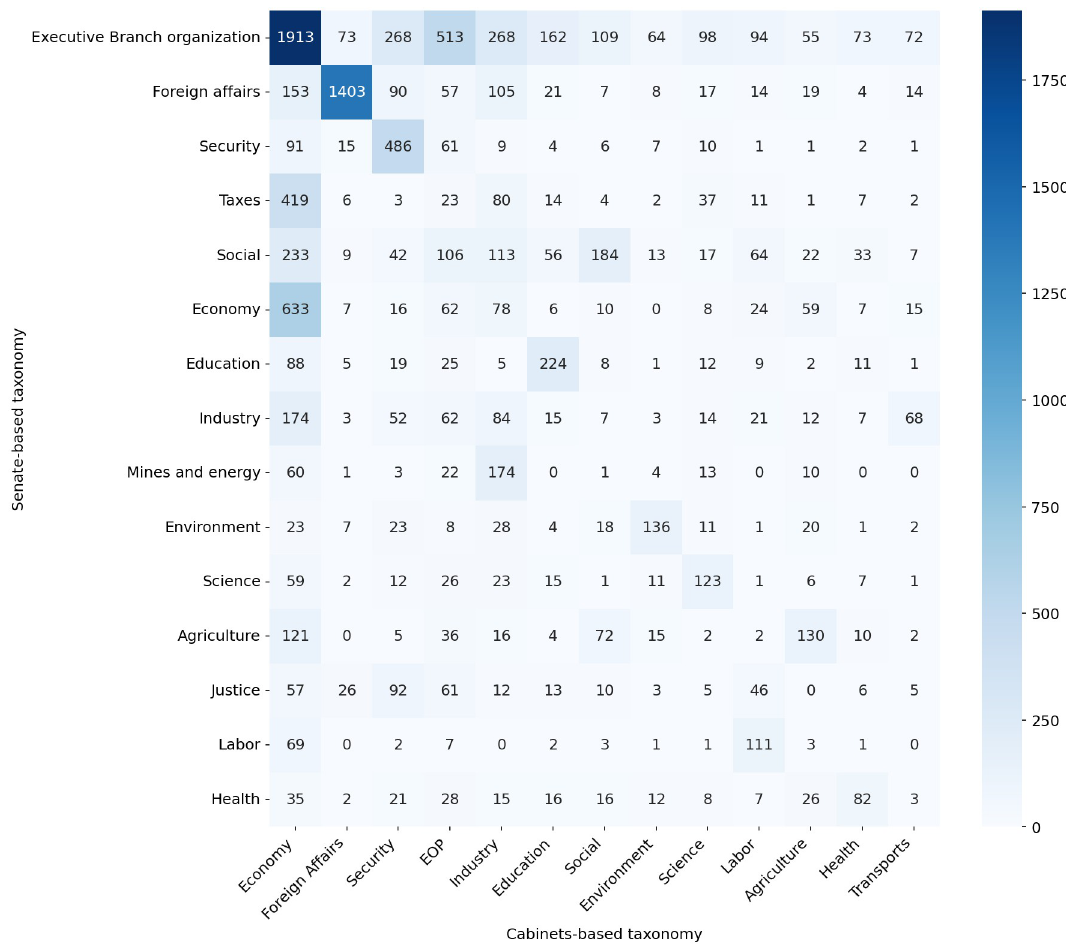
Fig 8. Overlap between the Senate and cabinets-based